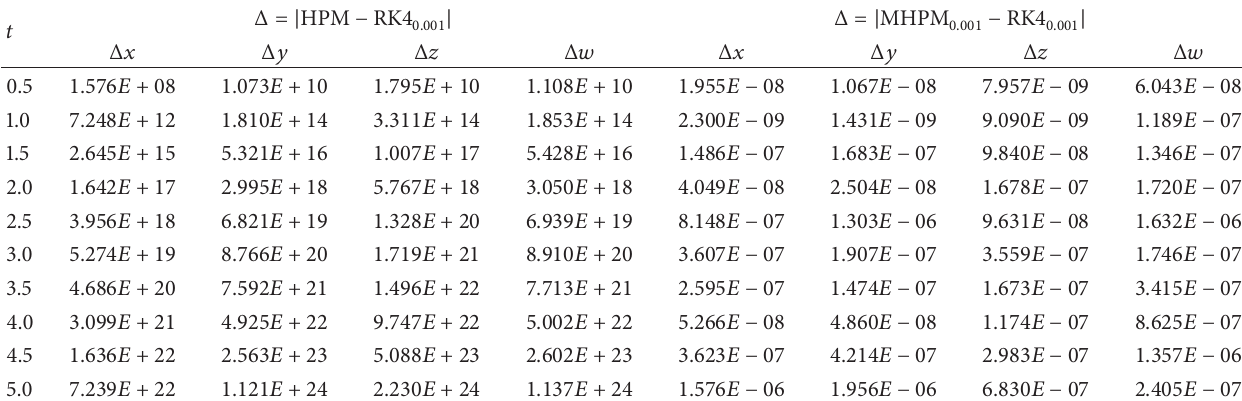
Table 6: Differences between 15-term HPM and 15-term MHPM with RK4 solutions on Δ𝑡 = 0.001